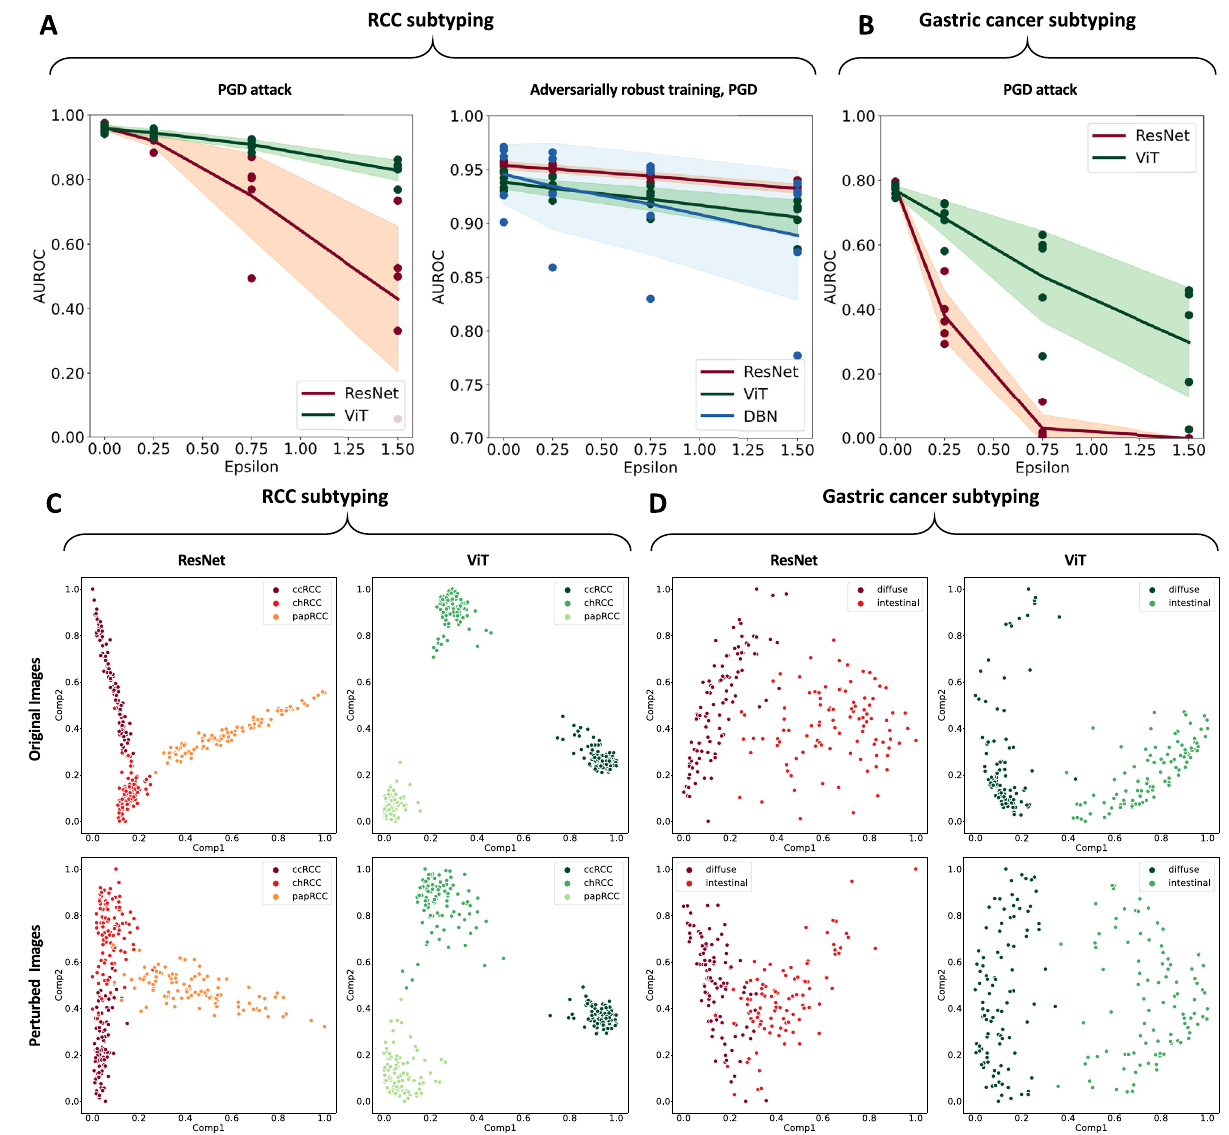
Fig. 3 | Vision transformers are more robust to adversarial attacks than con- volutional neural networks. A Micro-averaged AUROC for ResNet and ViT under PGD attack for RCC subtyping without (left) and with (right) adversarially robust training. Epsilon * 10E-3. This fi gure shows the mean AUROC of fi ve experi- ments±the standard deviation. B AUROC for ResNet and ViT for gastric cancer subtyping. ɛ * 10e-3. This fi gure shows the mean AUROC of fi ve experiments±the